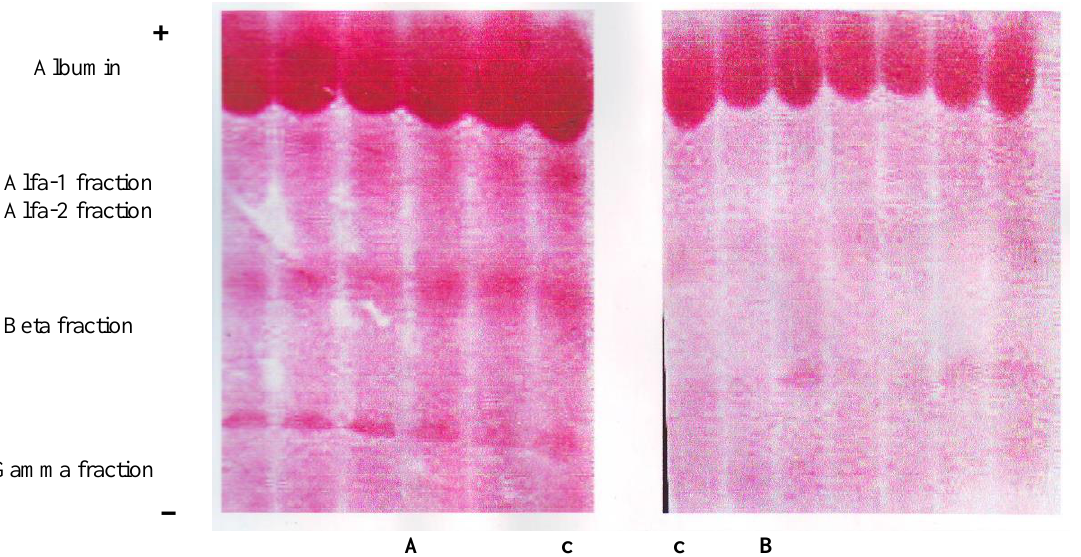
Figure 1 : Serum protein Electrophoresis Pattern (c control) A- (left):Normal control and major β-thalassemia patients B-(right):Normal control and pathologicalcontrol